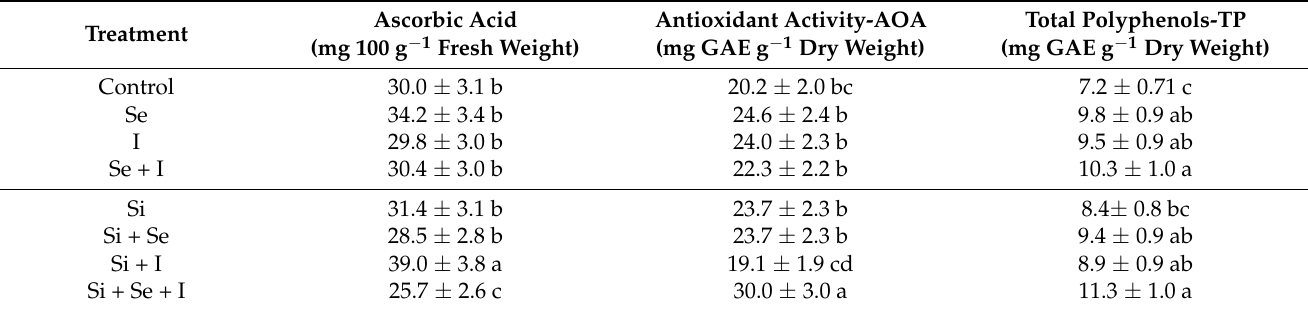
Table 3. Total antioxidant activity and phenolic content of chervil leaves under Se, I and Si supplementation. Treatment